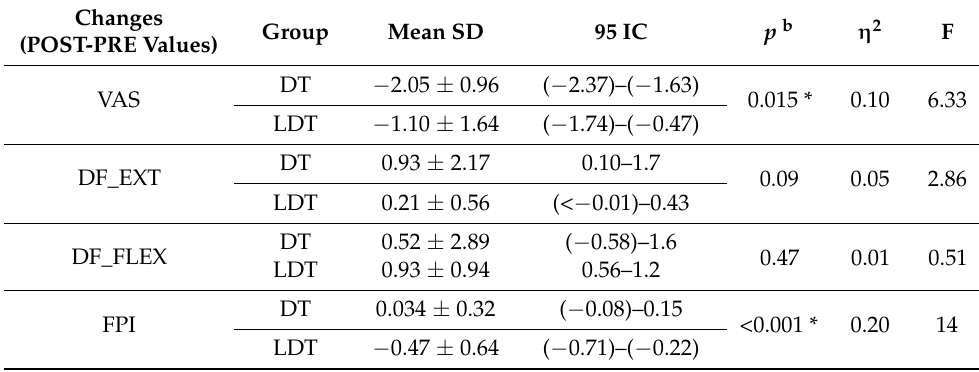
Table 3. Changes in variables from baseline to one week after tape colocation. Comparison between groups. Mean ± standard